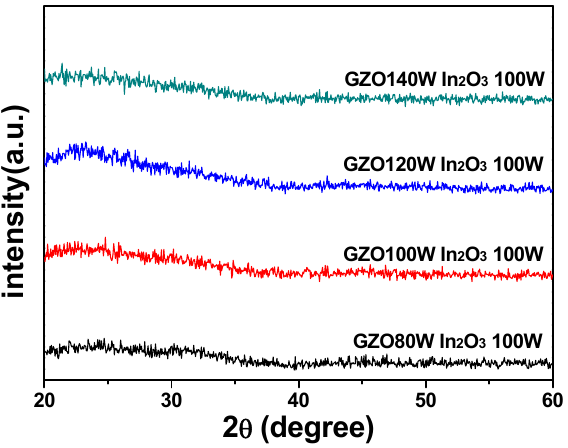
Figure 1. X-ray diffraction (XRD) patterns of In-Ga-Zn-O (IGZO) thin films as a function of deposition power of GZO ceramic